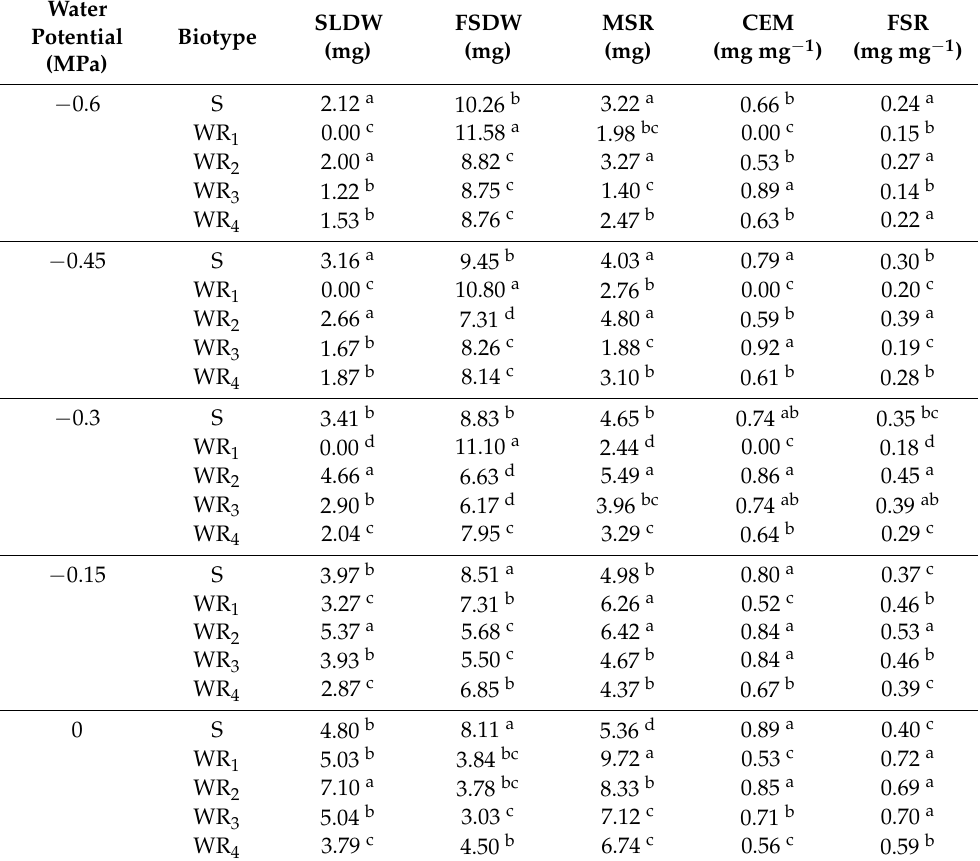
Table 7. Initial seedling dry weight (SLDW), seed remnants dry weight (FSDW), the weight of mobilized seed reserve (MSR), the conversion efficiency of mobilized (CEM), and the fraction of seed reserve (FSR) for susceptible biotype (S) or resistant biotypes (WR 1 –WR 4